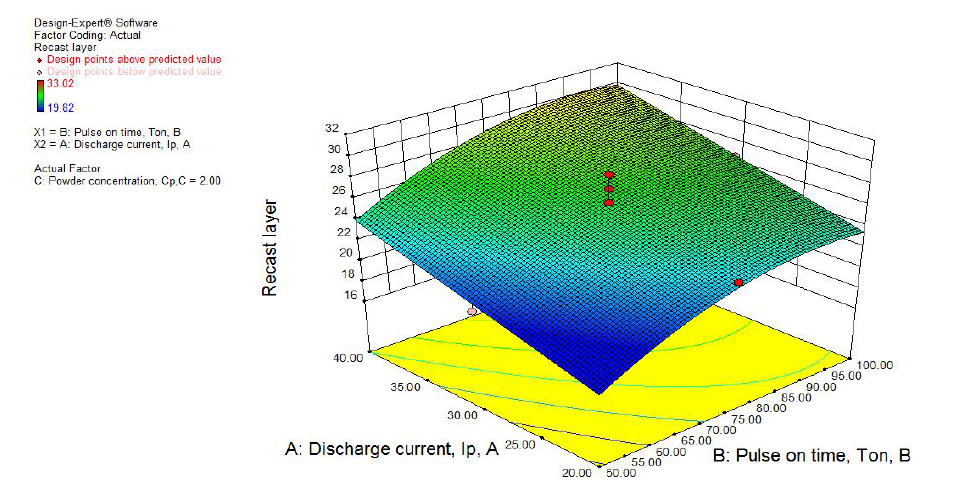
Figure 5: Three dimensional surface graph for recast layer between discharge current and pulse on time